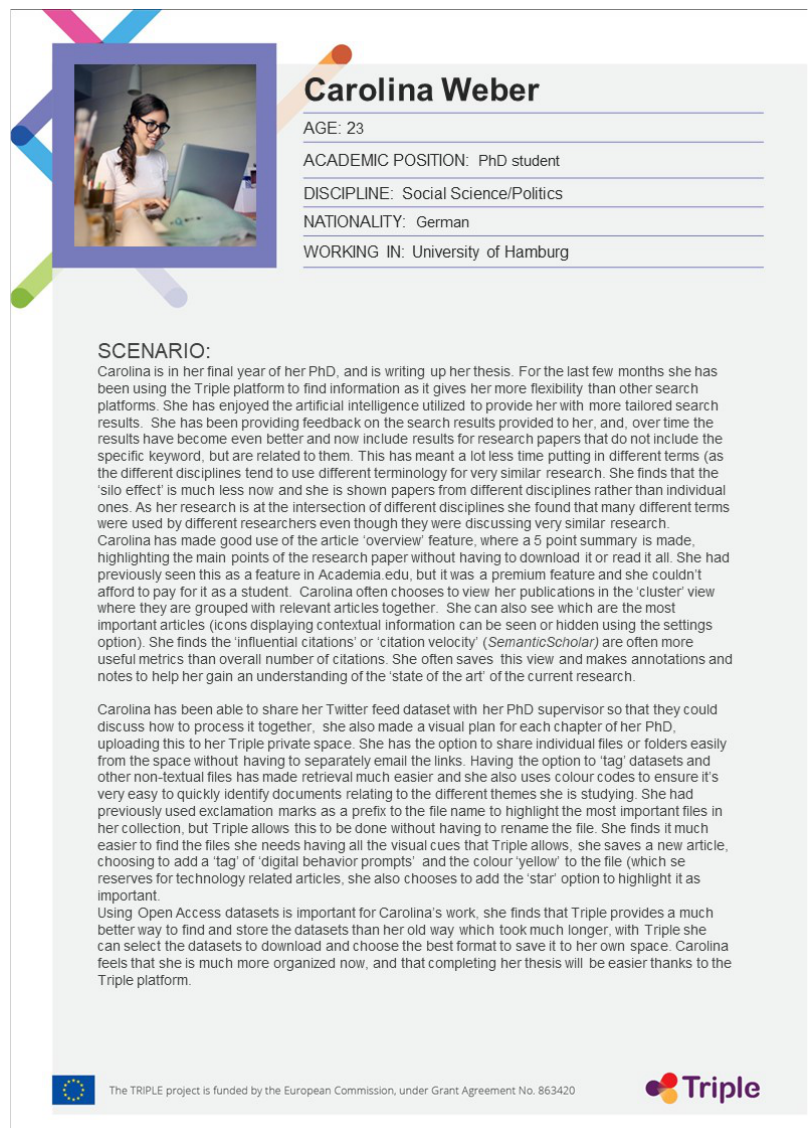
Fig. 2 . Example of an academic scenario created from the results of the requirement